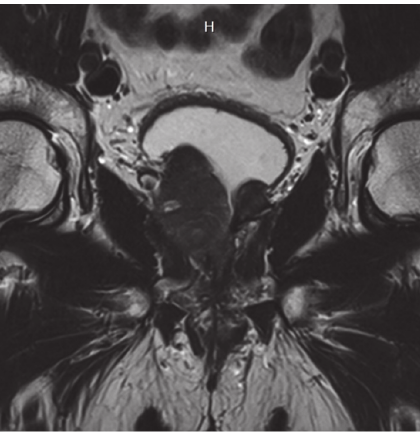
Figure 1: Coronal image of prostate showing extensive prostate cancer growth on the left side filling simple prostatectomy defect.